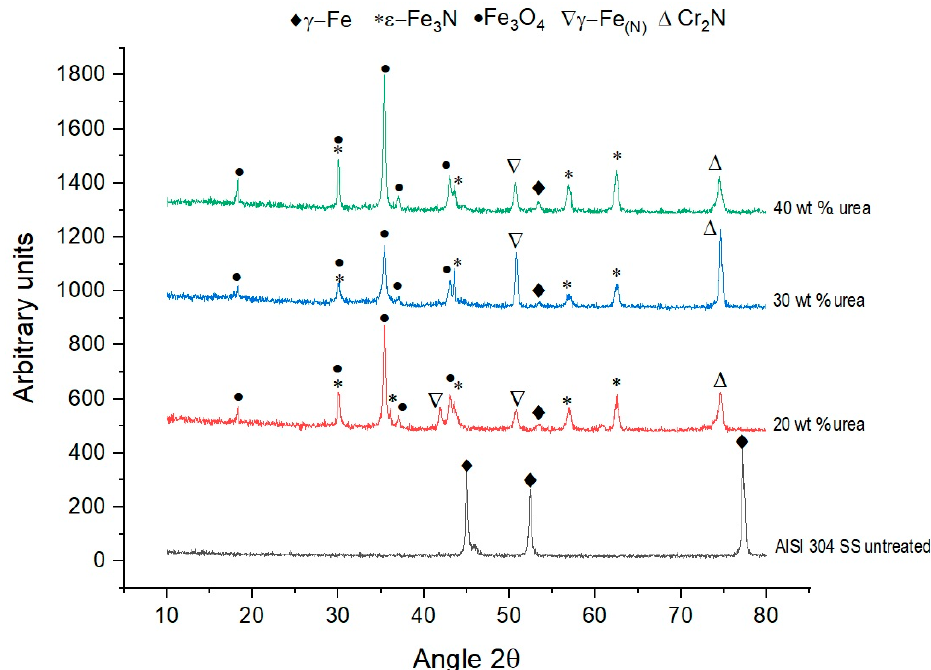
Figure 7. Diffraction patterns of oxy-nitrided AISI 304 SS, using different urea concentrations. The concentrations of each iron species present on the surface are shown in Table 2. The highest number of spinel-type oxides (Fe 3 O 4 , FeCr 2 O 4 ) was obtained in the sample